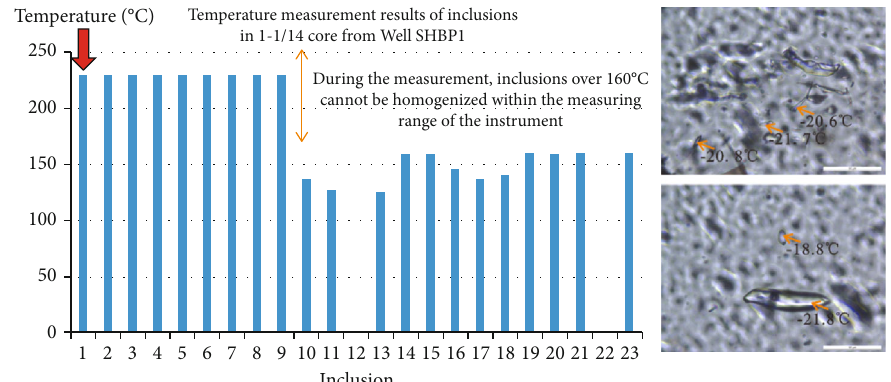
Figure 6: Inclusion temperature characteristics.